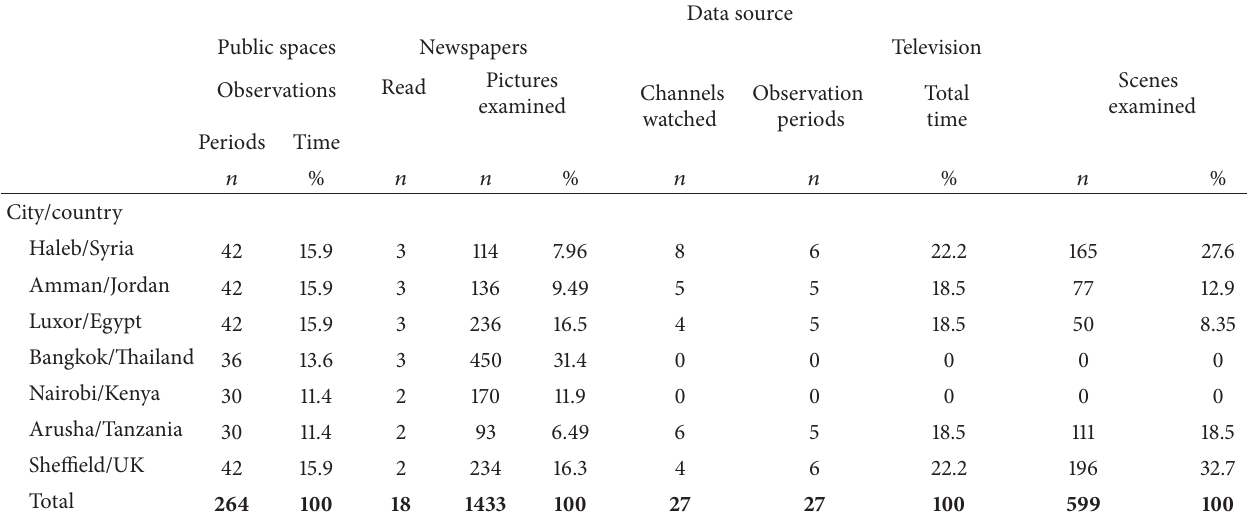
Table 1: Observations of older people in public places and in